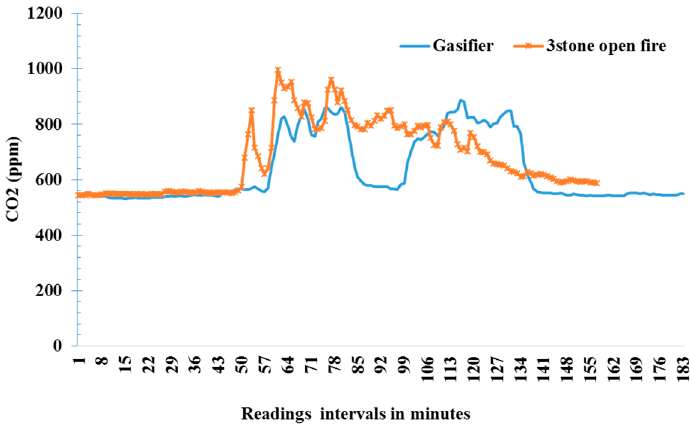
Figure 7. Concentration of CO 2 before, during and after the end of the cooking when using gasifier and three-stone open fire in the household No. 14.